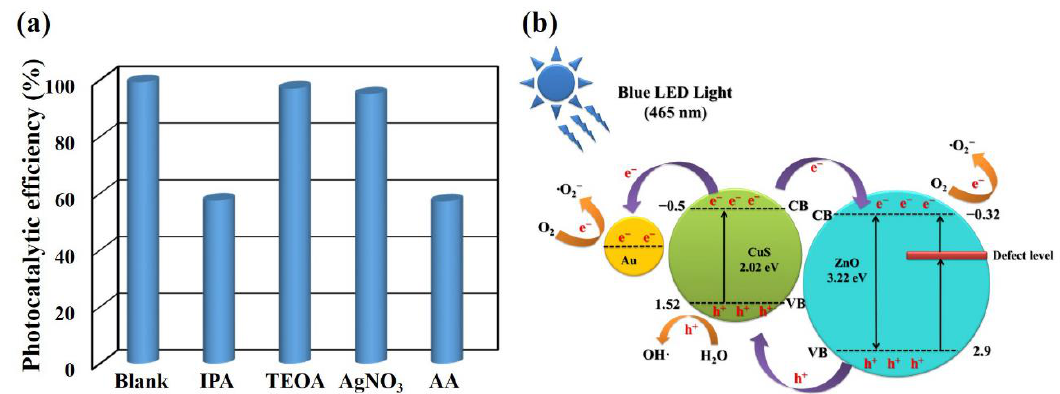
Figure 8. ( a ) Photocatalytic activities of Er-doped ZnO/CuS/Au core-shell nanowires with various scavengers under blue LED light. ( b ) Schematic diagram of the electron transfer mechanism of Er-doped ZnO/CuS/Au core-shell nanowires under blue LED light.